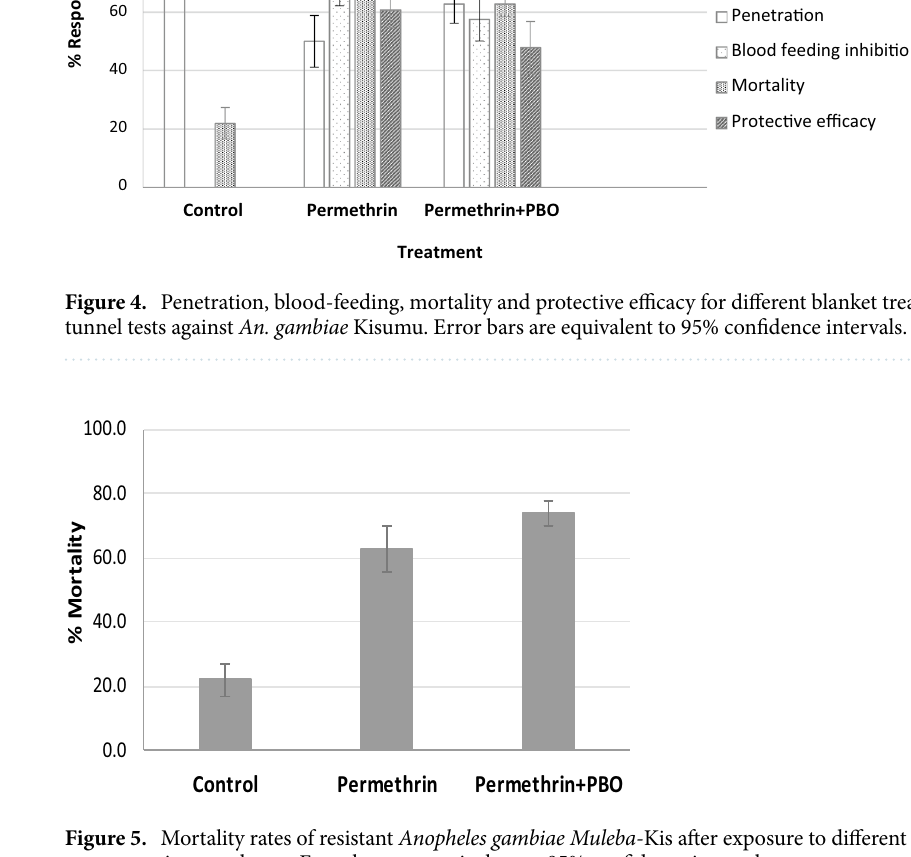
Figure 5. Mortality rates of resistant Anopheles gambiae Muleba -Kis after exposure to different blanket treatments in tunnel tests. Error bars are equivalent to 95% confidence intervals.